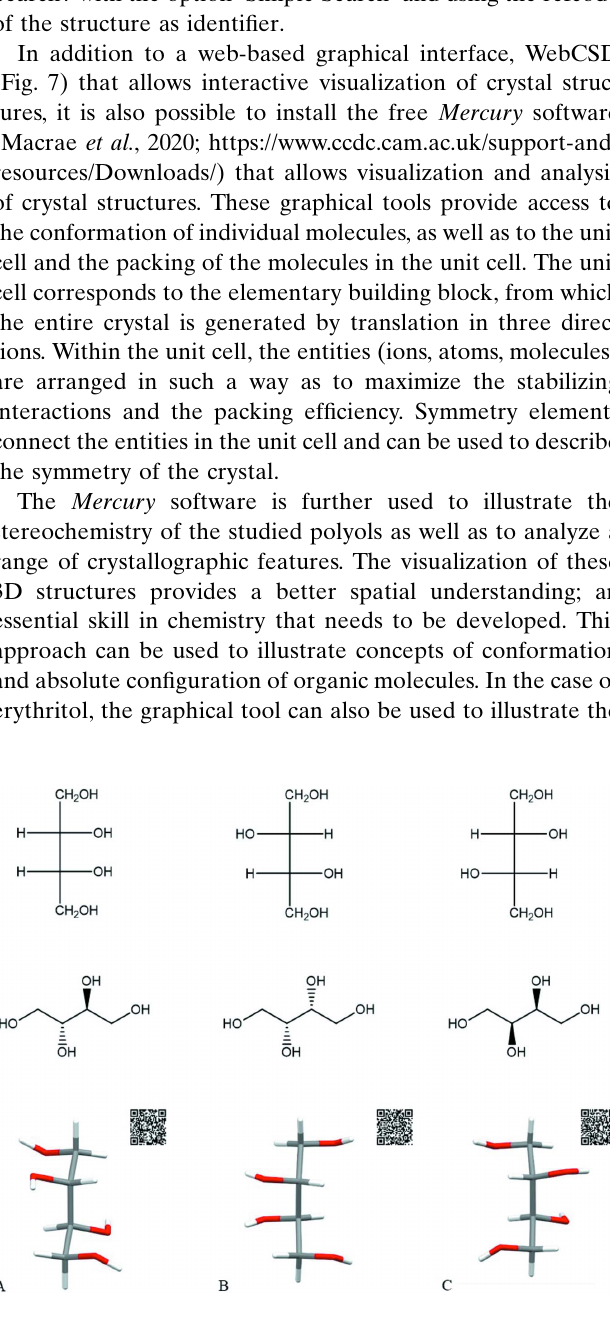
Figure 8 Illustration of the isomers of butane-1,2,3,4-tetrol using the 2D Fisher projection (top), structural formula (middle) and 3D structure (bottom) for meso -erythritol (A), d -threitol [(2 R ,3 R )-butane-1,2,3,4-tetrol] (B) and l -threitol [(2 S ,3 S )-butane-1,2,3,4-tetrol] (C). The 3D structure is based on the crystal structures of meso -erythritol (MERYOL03), d -threitol (PAGDEG) and l -threitol (LEDPUF). QR codes (also given in the supporting information) can be used for WebCSD access.